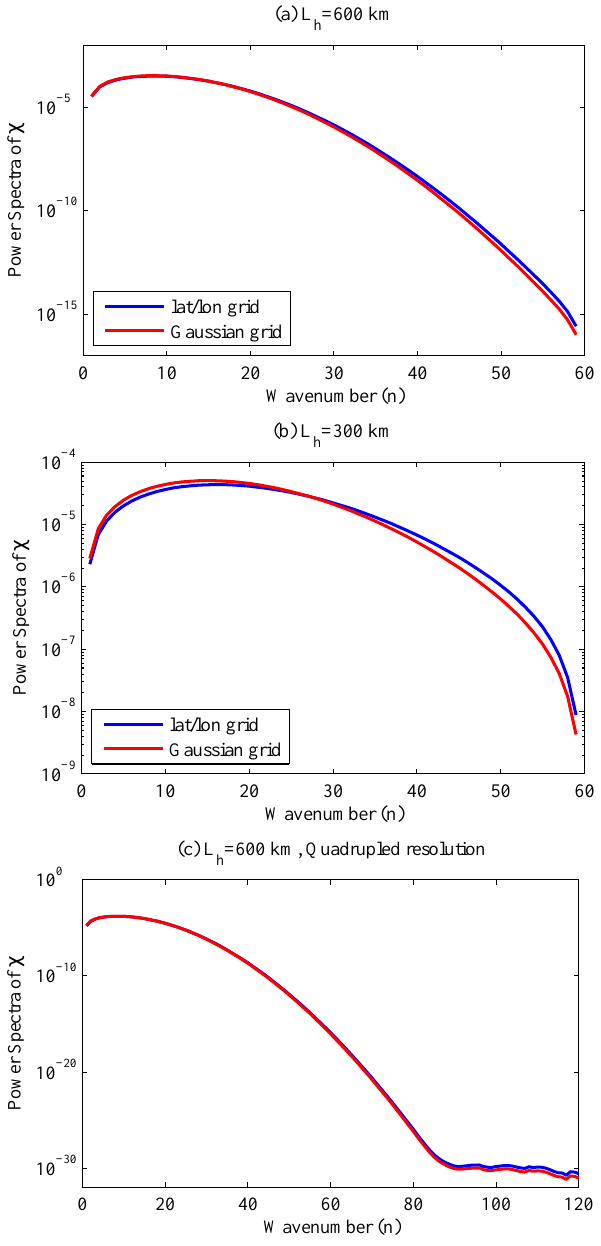
Fig. 2. Power spectra of the analysis increments χ at the observation level obtained using two different spectral grids – the lat/lon grid (blue line) and the Gaussian grid (red line). Panels (a) and (b) are obtained using a correlation length scales of L h = 600km (a) and 300km, respectively. In both cases, the experiments are based on a model resolution of 120 longitudes by 60 latitudes and 31 levels. Results on panel (c) are obtained with L h = 600km and a model resolution of 240 longitudes by 120 latitudes and 31